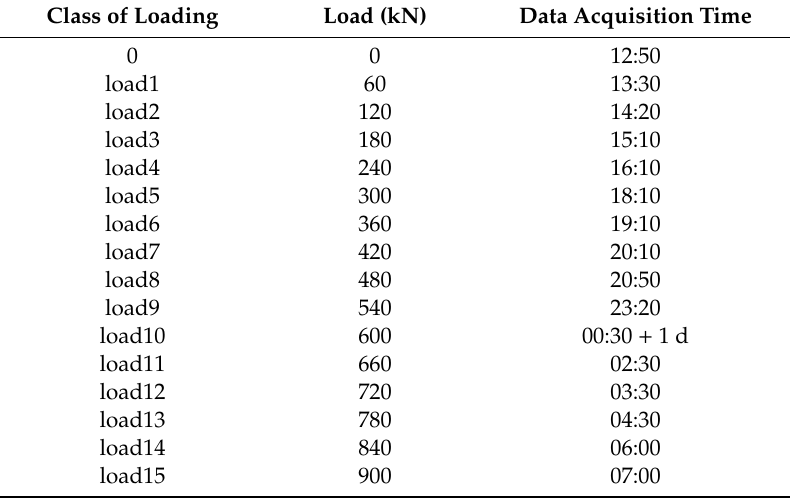
Table 1. Information of horizontal